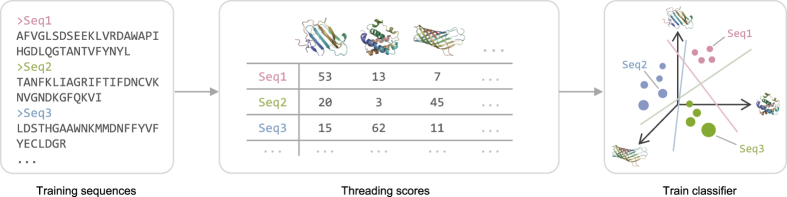
Overview of PESS construction.Training sequences of known fold are threaded against a set of structure templates, and the resulting threading scores act as coordinates within a structural feature space (the PESS). A classifier can then be trained to recognize the subspace occupied by each fold in the PESS. Different colors indicate the fold of each sequence and are shown here only for visualization.